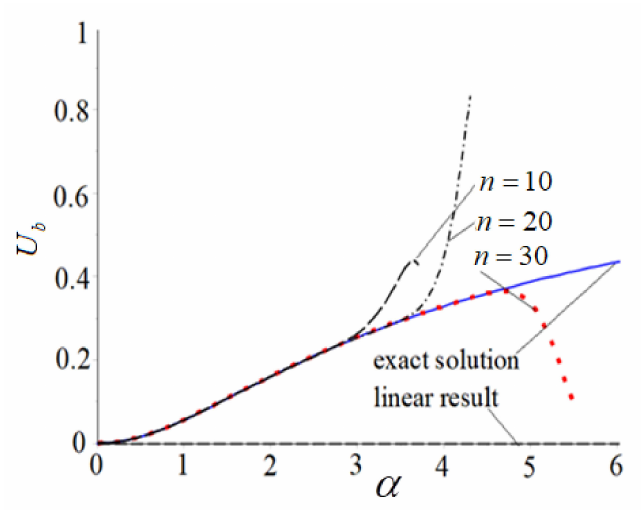
Figure 3. Horizontal displacement at free